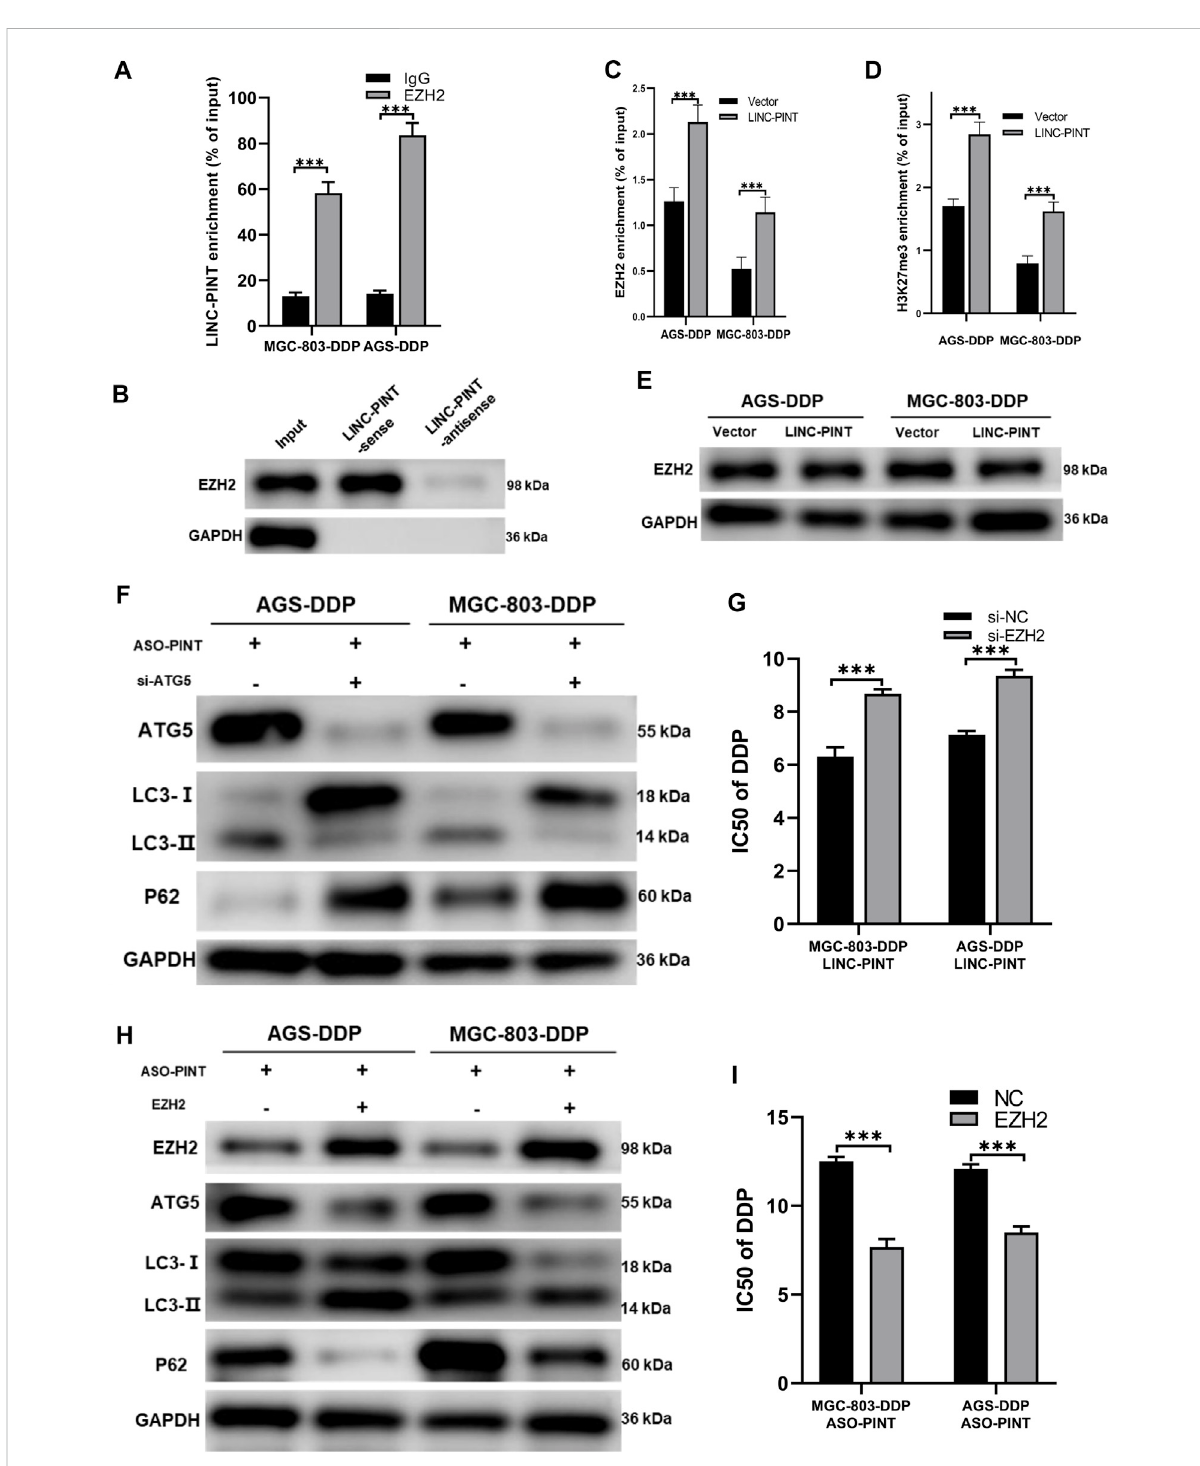
FIGURE 6 LINC-PINT regulates ATG5 via EZH2. (A) RIP assay showing the interaction between LINC-PINT and EZH2. (B) RNA pull-down assay showing the interaction between LINC-PINT and EZH2. (C) ChIP assay showing EZH2 enrichment in the promoter region of ATG5 of LINC-PINT- overexpressing DDP-resistant cells. (D) ChIP assay showing H3K27me3 enrichment in the promoter region of ATG5 in controls or LINC-PINT- overexpressing DDP-resistant cells. (E) Western blotting showing EZH2 expression in LINC-PINT-overexpressed DDP-resistant cells. (F) Western blotting showing EZH2, ATG5, LC3 and p62 expression in LINC-PINT-overexpressed and EZH2 silenced DDP-resistant cells. (G) CCK-8 assay for LINC-PINT-overexpressed and EZH2-silenced DDP-resistant cells to evaluate the IC50 of DDP. (H) Western blotting evaluating EZH2, ATG5, LC3, and p62 expression in LINC-PINT-silenced and EZH2 overexpressed DDP-resistant cells. (I) CCK-8 assay for LINC-PINT-silenced and EZH2-overexpressed DDP-resistant cells to evaluate the IC50 of DDP. Data are represented as the mean ± SD. * p ＜ 0.05. ** p < 0.005. *** p < 0.001. The experiments were repeated independently at least three